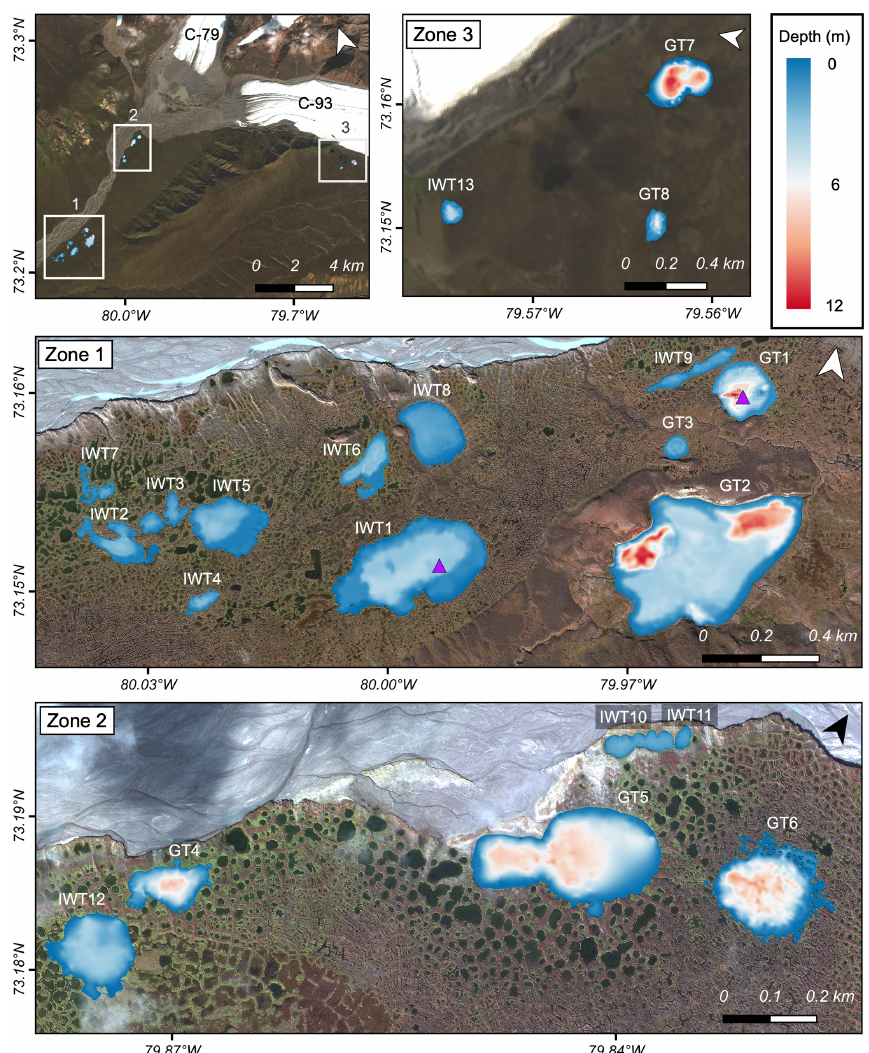
Figure 3. Bathymetric maps of the 21 lakes surveyed in the Qarlikturvik Valley (background: GeoEye, 2010). The yellow stars show the location of massive ice exposures. Purple triangles on lakes IWT1 and GT1 indicate sediment coring locations. Glacial thermokarst lakes (max depth > 4m): GT 1 to 8; ice-wedge thermokarst lakes (max depth < 4m): IWT1 to